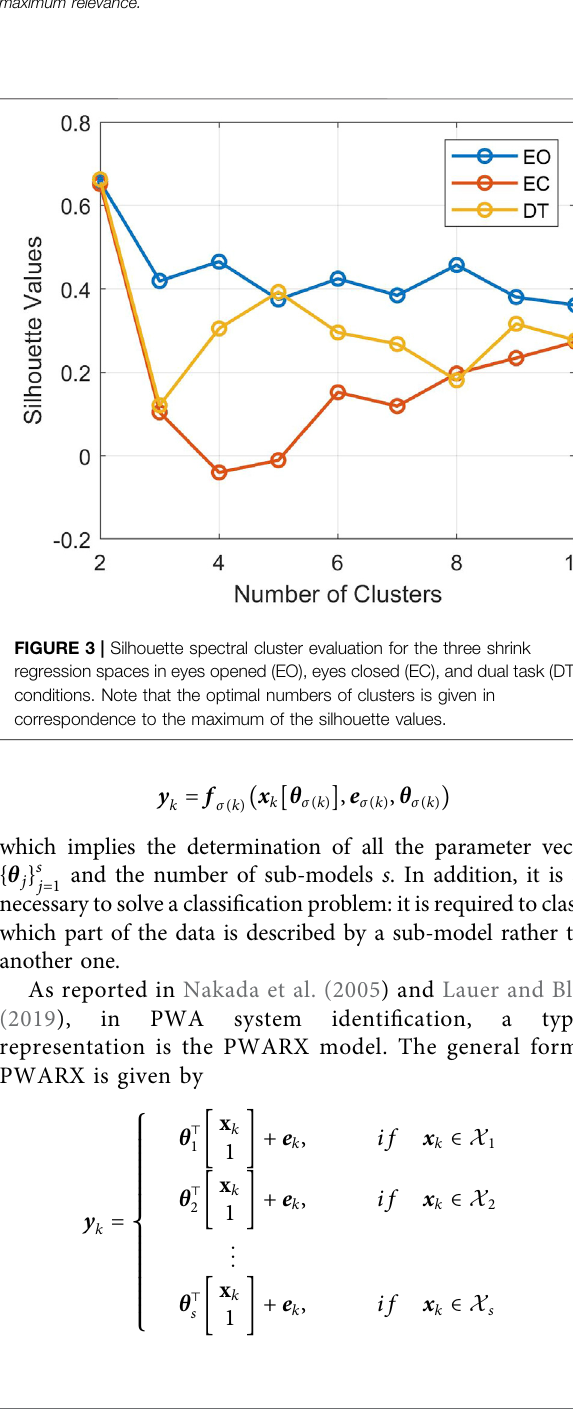
Frontiers in Bioengineering and Biotechnology |